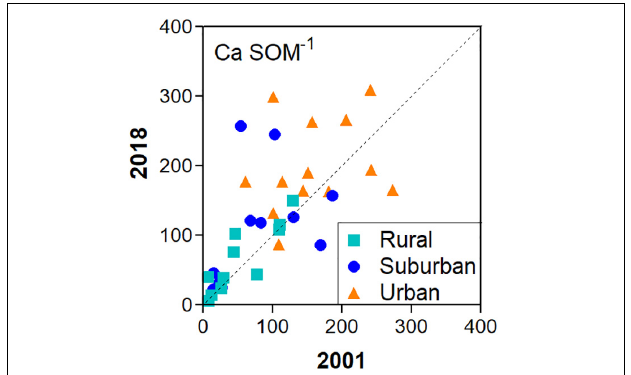
FIGURE 4 | Correlation between surface soil calcium levels in 2001 and 2018. Ca concentrations are normalized by soil organic matter (SOM). Corresponding values are shown at the plot level ( n = 36). The relationship is significant in the rural sites ( r 2 = 0.75, P = 0.0005), but not in the suburban ( r 2 = 0.23, P = 0.11), and urban ( r 2 = 0.079, P = 0.35) sites. The dotted line is the 1:1 line.